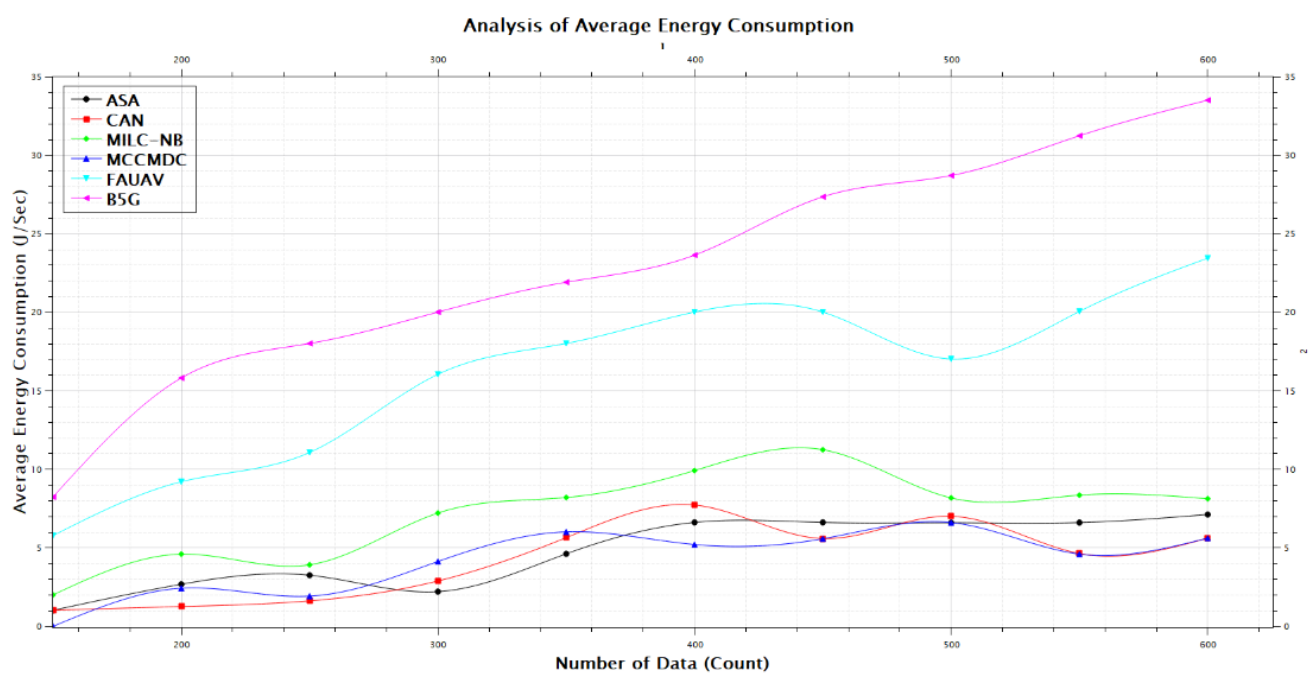
Figure 6. The average energy consumption before data obfuscation.